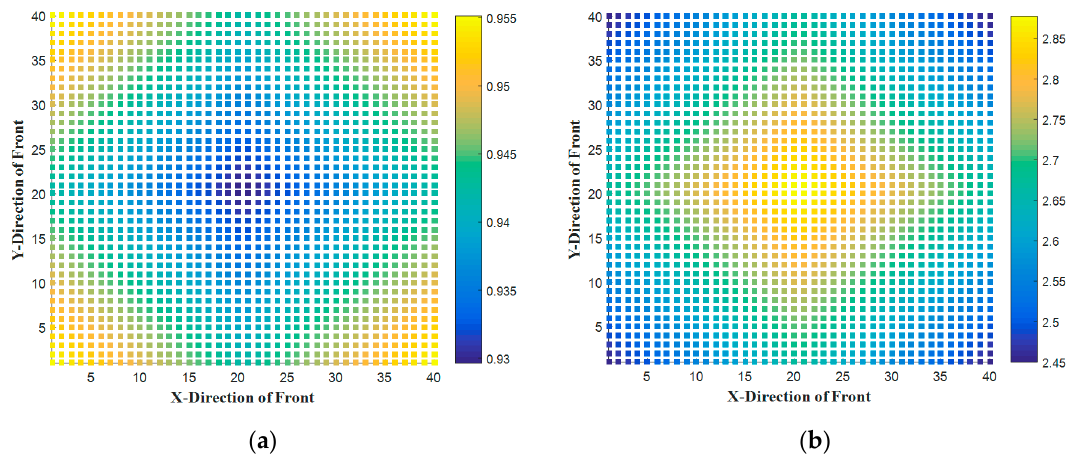
Figure 10. ( a ) Magnitude error; ( b ) phase error under effect of symmetric temperature distribution. T is determined as below from Figure 9a, which can be used to quickly evaluate the temperature m